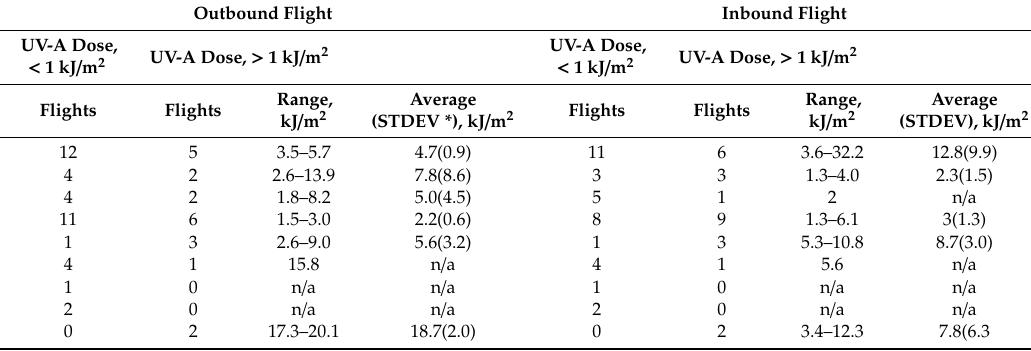
Summary of the morning departure flights (departure time before 9 am UTC) in the south of Europe (36 ◦ 40 (cid:48) –46 ◦ 14 (cid:48) ) N (7 ◦ 58 (cid:48) W–12 ◦ 21 (cid:48) ) E, the Canary Islands (28 ◦ 2 (cid:48) –32 ◦ 42 (cid:48) ) N